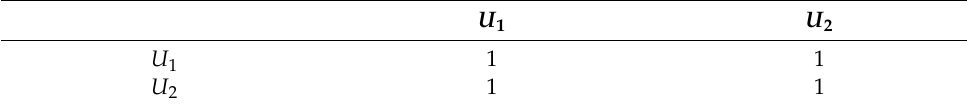
Table 11. Modified scoring table of geological condition.